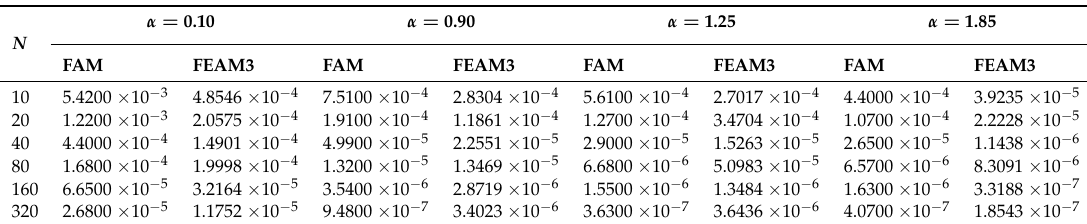
Table 3. Absolute error at point, t = 1 when solving Example 1 using FEAM3 and FAM for different values of α and N